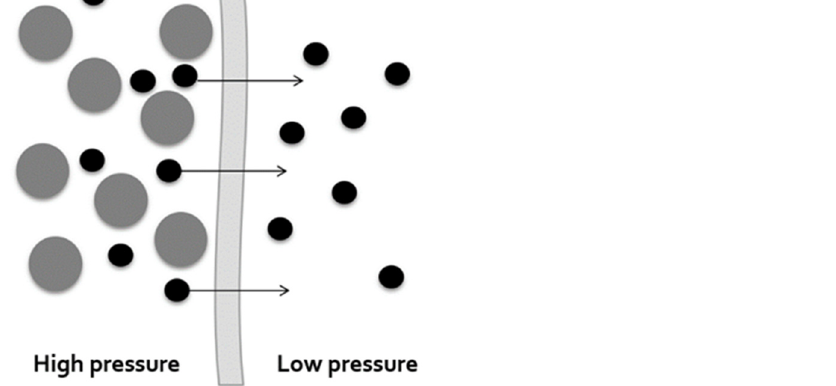
Figure 1. Schematic diagram showing the working principle of the gas-separation membrane.